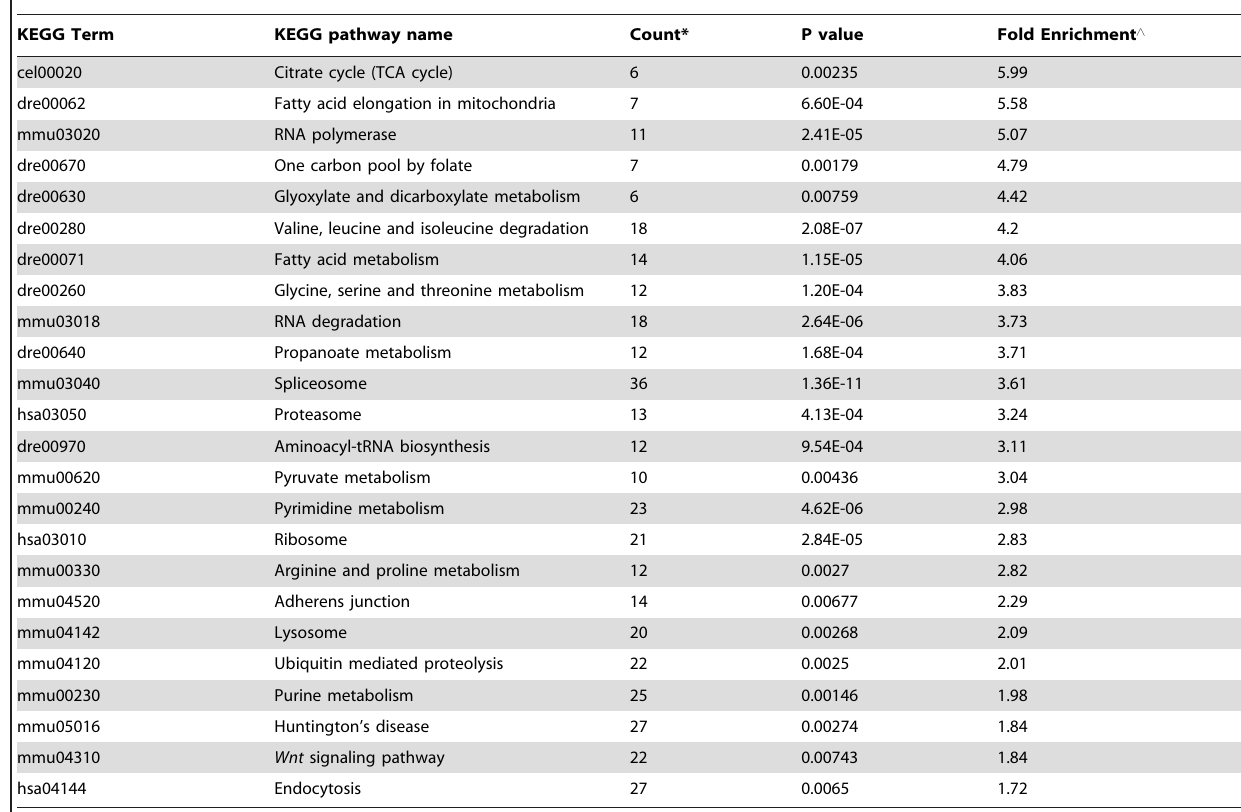
Table 1. Enriched KEGG pathways identified by DAVID analysis.